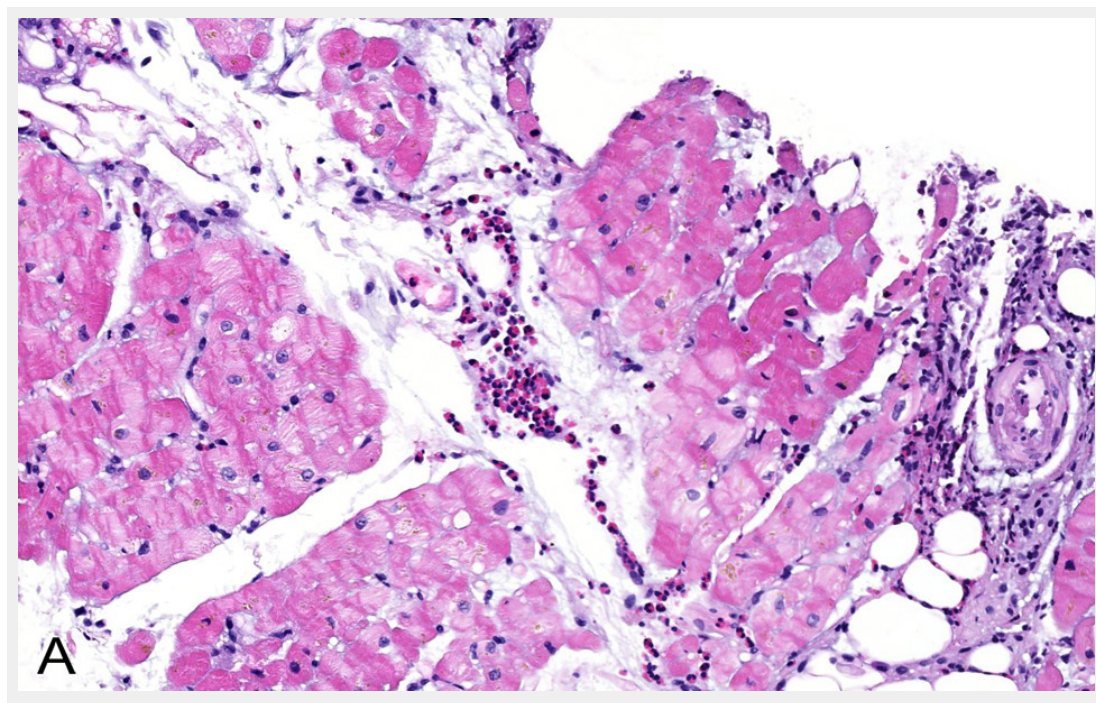
Figure 3A Intramyocardic vessels showing luminal eosinophils which were also found in the surroundig interstitium and between the myocardial fibers (H&E stain, 100x).